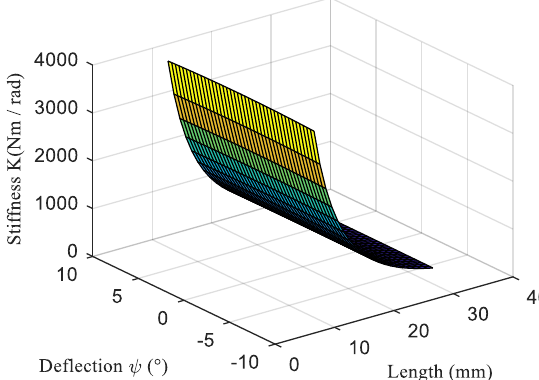
Figure 10. The relationship between the joint stiffness and the effective length and the passive deflection angle.